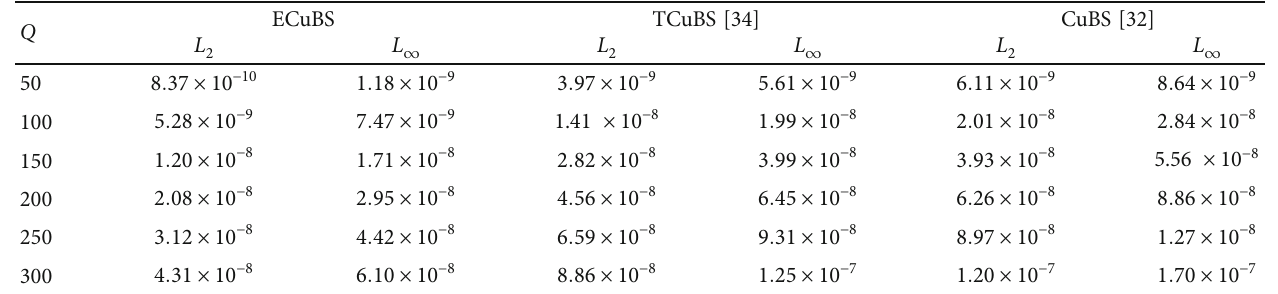
Table 2: Error comparison for Example 6 when N = 100 ,and Δ t = 10 − 5 .